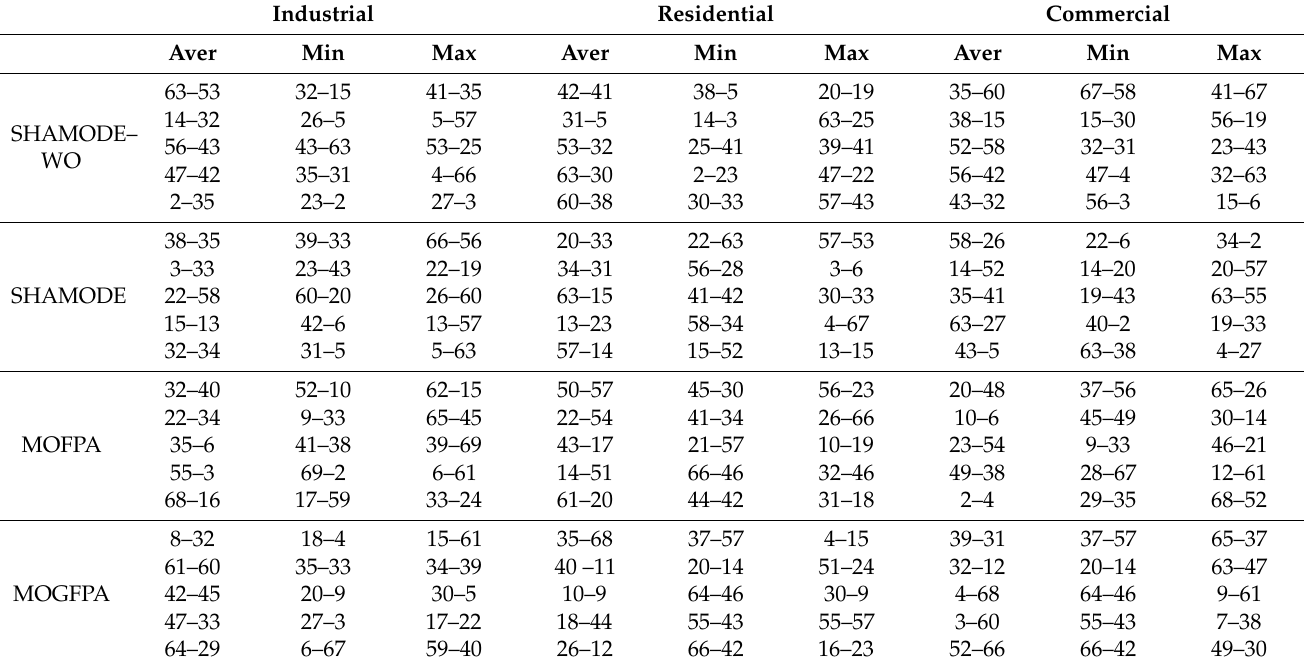
Table 4. Tie switches configuration (IEEE 69).